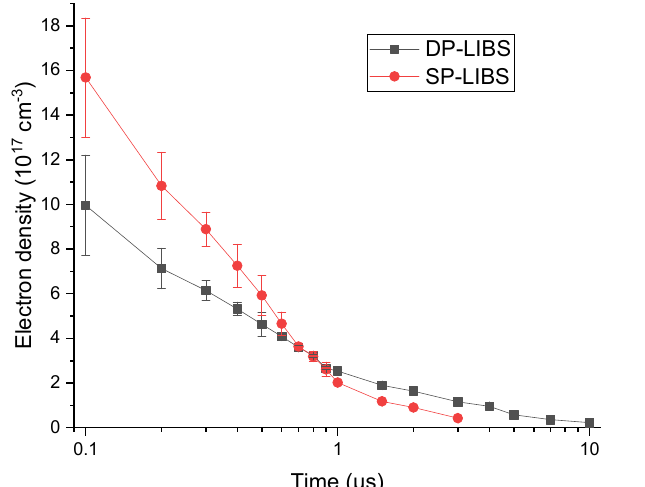
Figure 5. Time-resolved evolution of the electron density, obtained from the Stark broadening for SP-LIBS and DP-LIBS experiments.